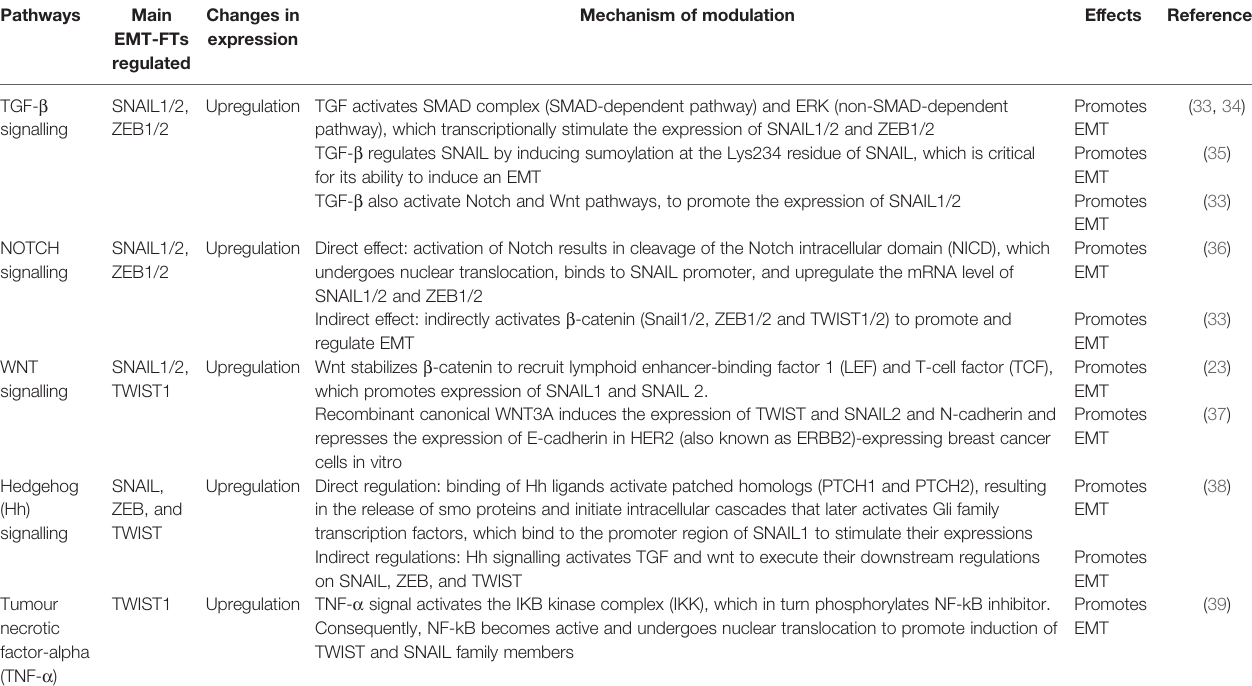
TABLE 1 | Signalling pathways regulate